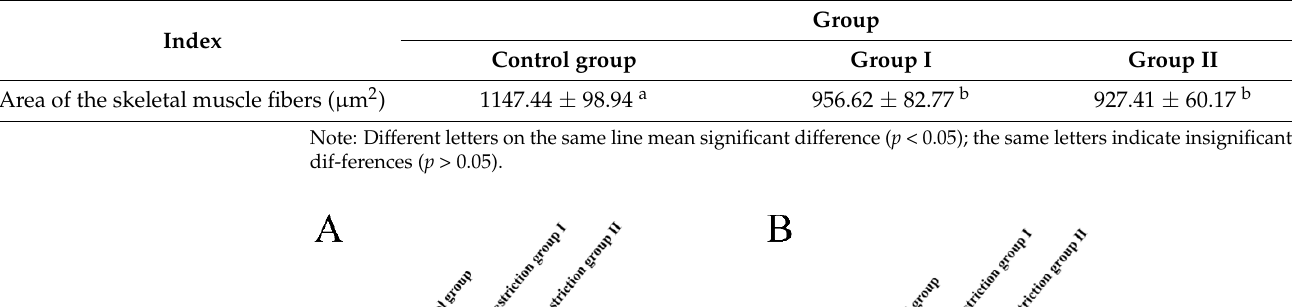
Figure 1. The HE staining image and effect of feed restriction associated with skeletal mus- cle development . ( A ) the HE staining image of the skeletal muscle of the control group, the re- stricted-feeding group I, and the restricted-feeding group Ⅱ, respectively; ( B ) effect of feed re- striction on the expression level of genes associated with skeletal muscle development; * indicated significant difference ( p < 0.05); ** indicated extremely significant difference ( p < 0.01). Table 10. ANOVA of the area of the skeletal muscle fibers. Table 10. ANOVA of the area of the skeletal muscle fibers.